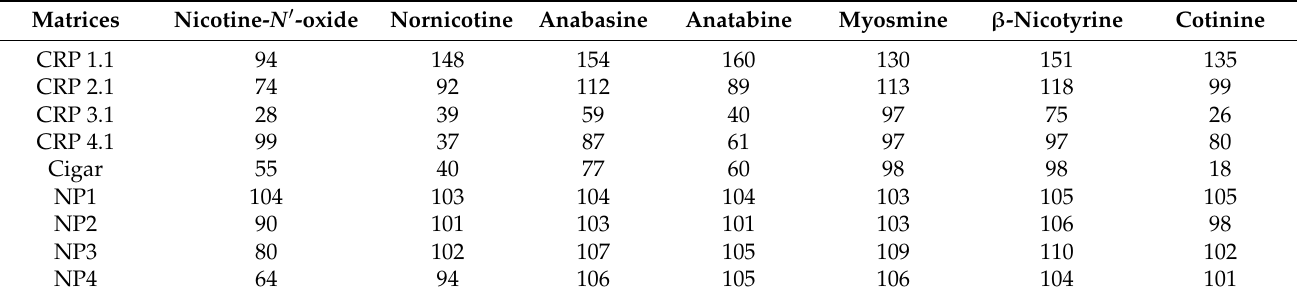
Table 7. Matrix effects (%) for all matrices.